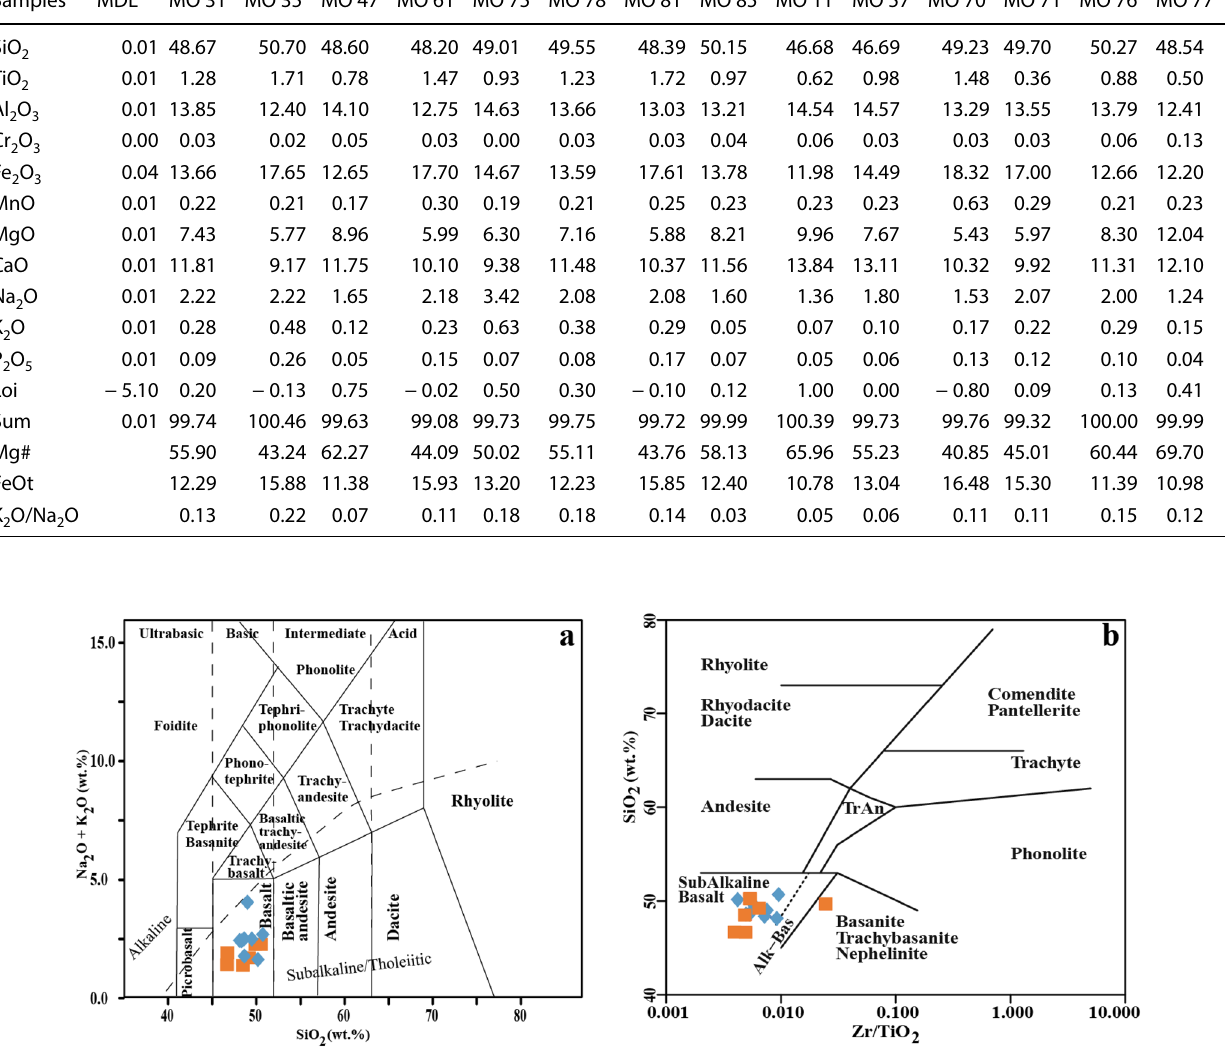
Table 2 Major elements (wt%) and CIPW norm compositions of studied samples Fine-grained garnet meta-mafic rocks Coarse-grained garnet meta-mafic rocks Samples